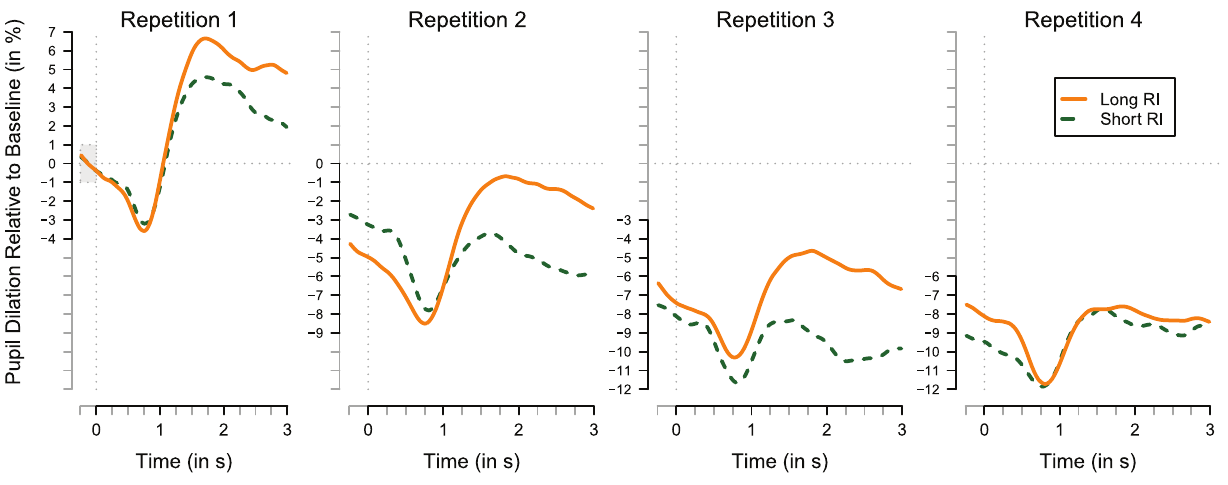
Figure 5. Averaged relative pupil dilation per repetition during the presentation of the retrieval cue, plotted separately for the long (orange, solid; 14 trials per participant) and short (green, dashed; 12 trials per participant) retention interval (RI) sets and aligned to the onset of the presentation of the retrieval cue at t=0. Pupil dilation is calculated as percentage change relative to the 250 ms before the first repetition, indicated by the grey box in the leftmost